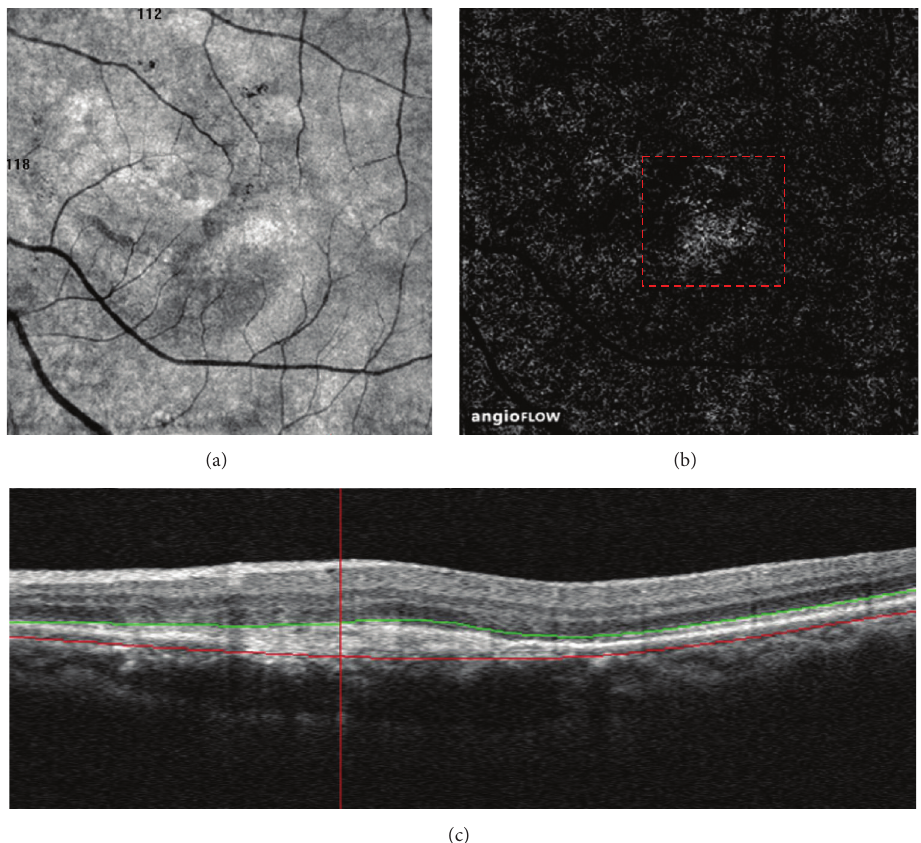
Figure 2: Distinguishing the choriocapillaris artifact from choroidal neovascularization (CNV). (a and b) A 6 ∗ 6 -mm En face angiogram of the outer retina from a 62-year-old woman who were previously treated with 18 intravitreal anti-VEGF injections showing a homogenous and ill-defined network of vessels with a granular appearance (red dashed box). (c) Spectral-domain optical coherence tomography displaying a fusiform or spindle-shaped complex of high reflectivity located within the subretinal space.